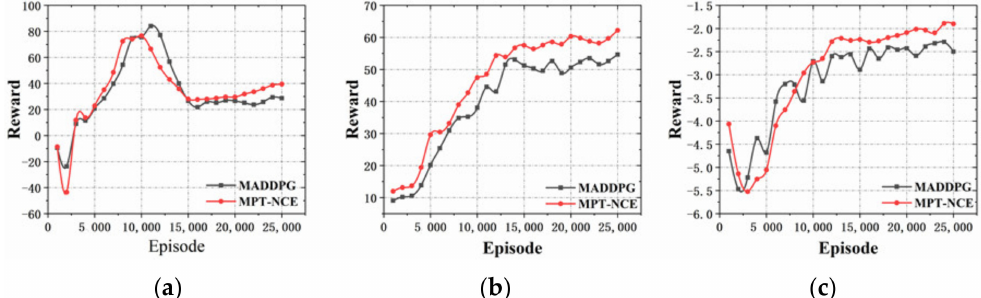
Figure 9. Reward function curve of tracking experiment: ( a ) shows the comparison chart of reward curve between the MPT-NCE method and MADDPG method, ( b ) shows the MPT-NCE method and MADDPG method of blue detection agents reward function curve comparison diagram, and ( c ) shows the MPT-NCE method and MADDPG method of red interference agents reward function curve comparison